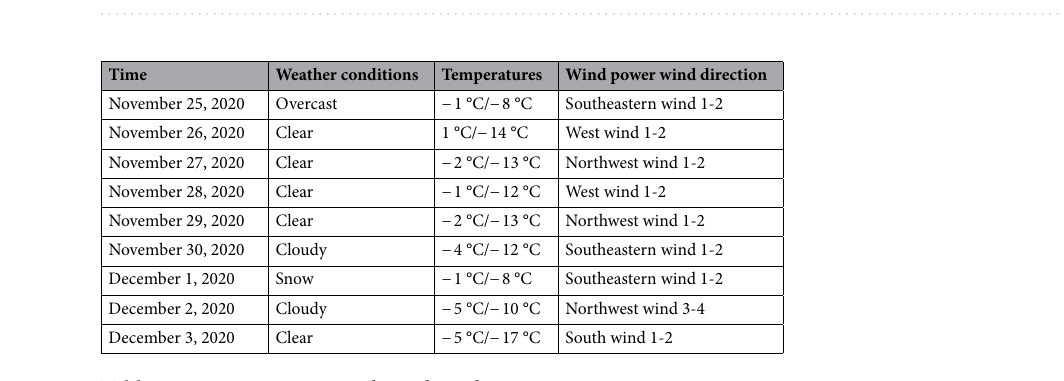
Table 3. Monitoring meteorological conditions.